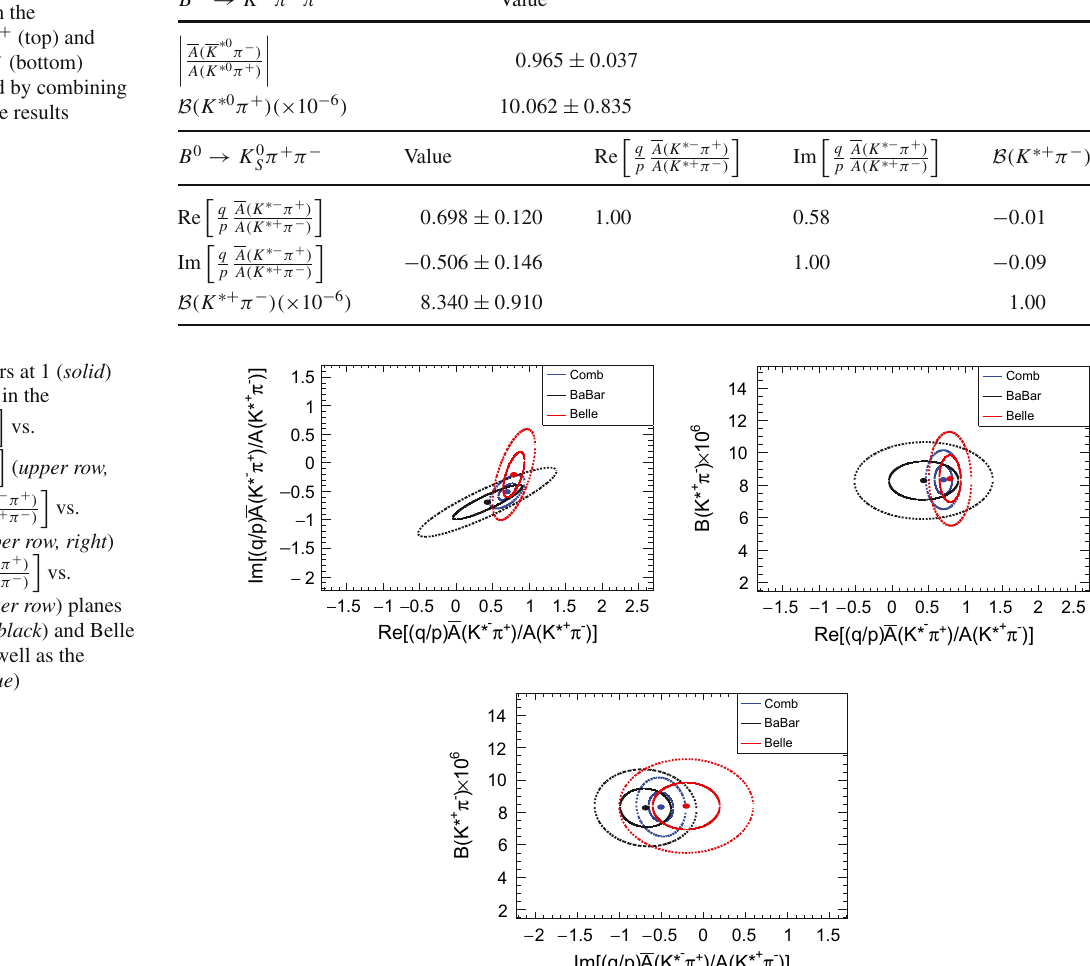
Fig. 15 Contours at 1 ( solid ) and 2 ( dotted ) σ in